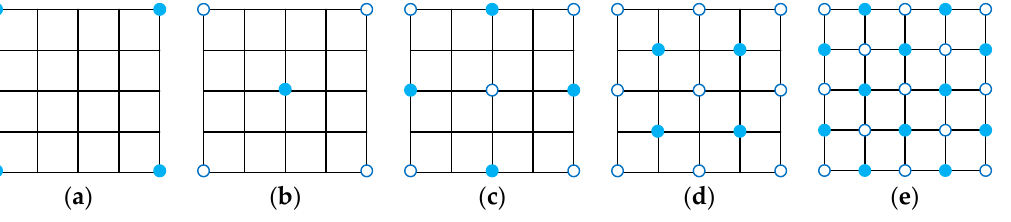
Figure A1. The schematic diagram of the implementation steps of Diamond-Square algorithm: ( a ) The initial points; ( b ) The generation of ceter point; ( c ) The generation of midpoint of each side of the square; ( d ) The generation of the intersection of the diagonals; ( e ) The generation midpoint of each side of the smaller square. The algorithm is initialized by planting several random seeds for the vertices of the square as their scattering coefficient values. The key calculation steps are: 1. Diamond Step: As shown in Figure A1b,d, suppose the coordinates of the lower left corner of the current square is ( x , y ) , calculate the scattering coefficient of the intersection of the diagonals of the square as follows: